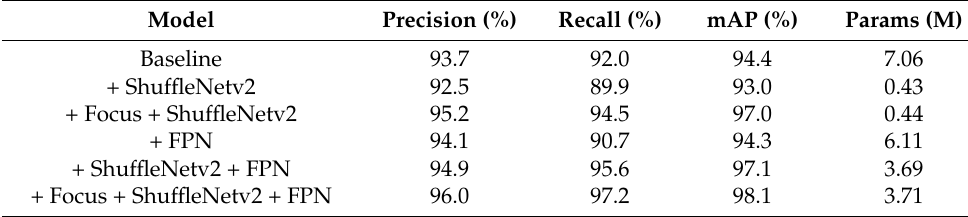
Table 2. Ablation study.